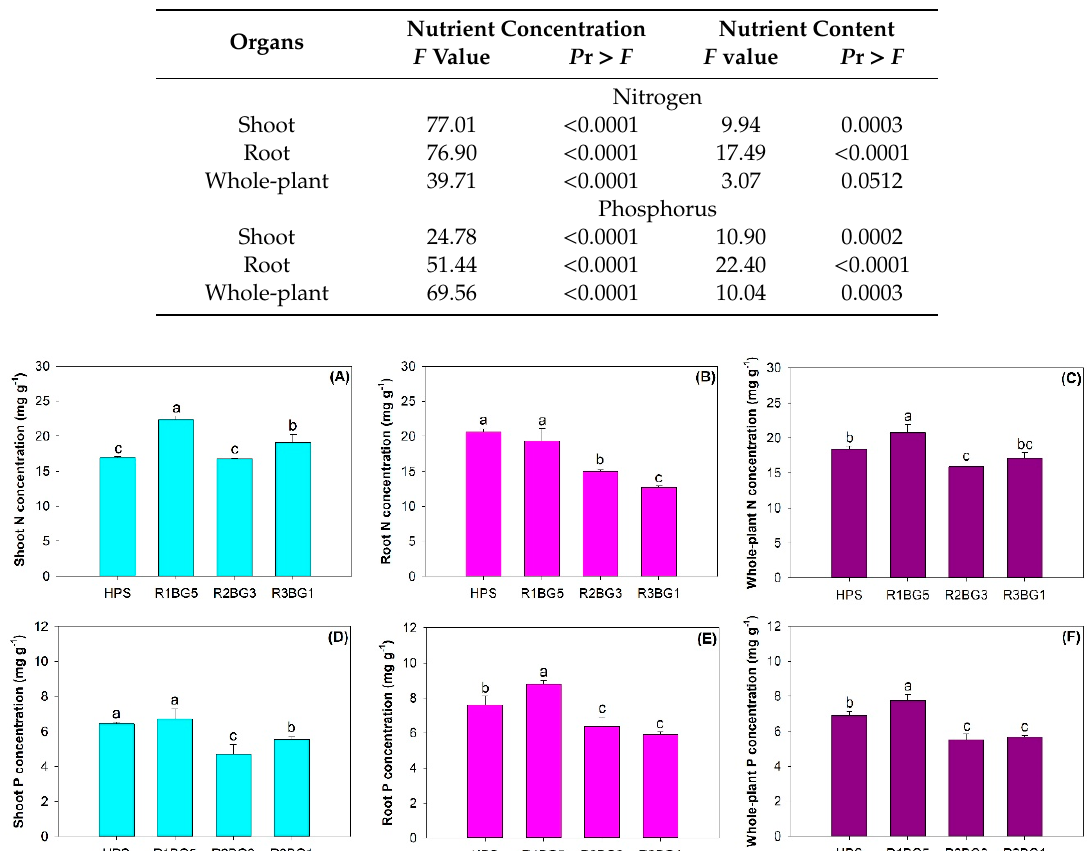
Table 2. ANOVA on nitrogen and phosphorus concentrations and contents in Korean pine ( Pinus koraiensis ) seedlings exposed to four regimes of artificial lighting spectra.